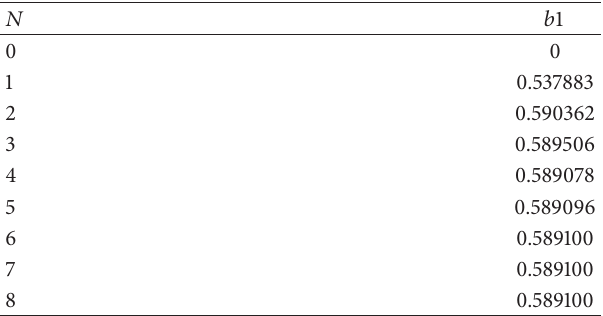
Table 2: Convergence results 𝛽 = 1 = 𝜆 = 𝛿 , 𝜖 = 0.1 .